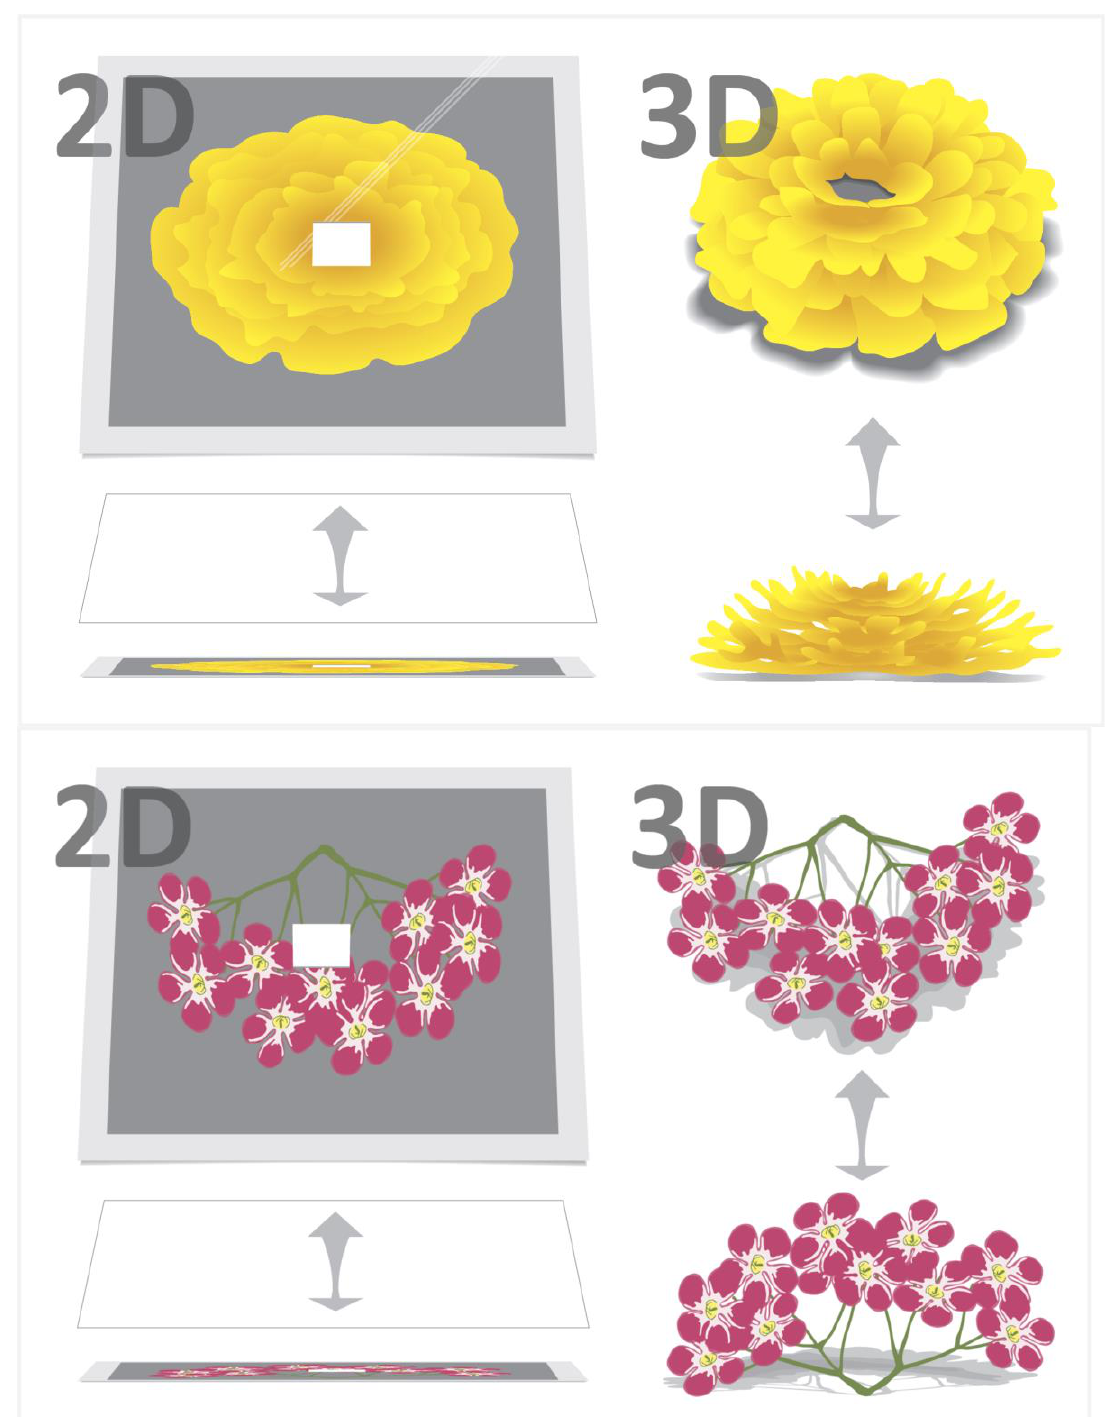
Figure 2. Images of Photo and Object X (on top) and Photo and Object Y (bottom). Object X reproduced from Thompson & Plowright (2014) with permission from